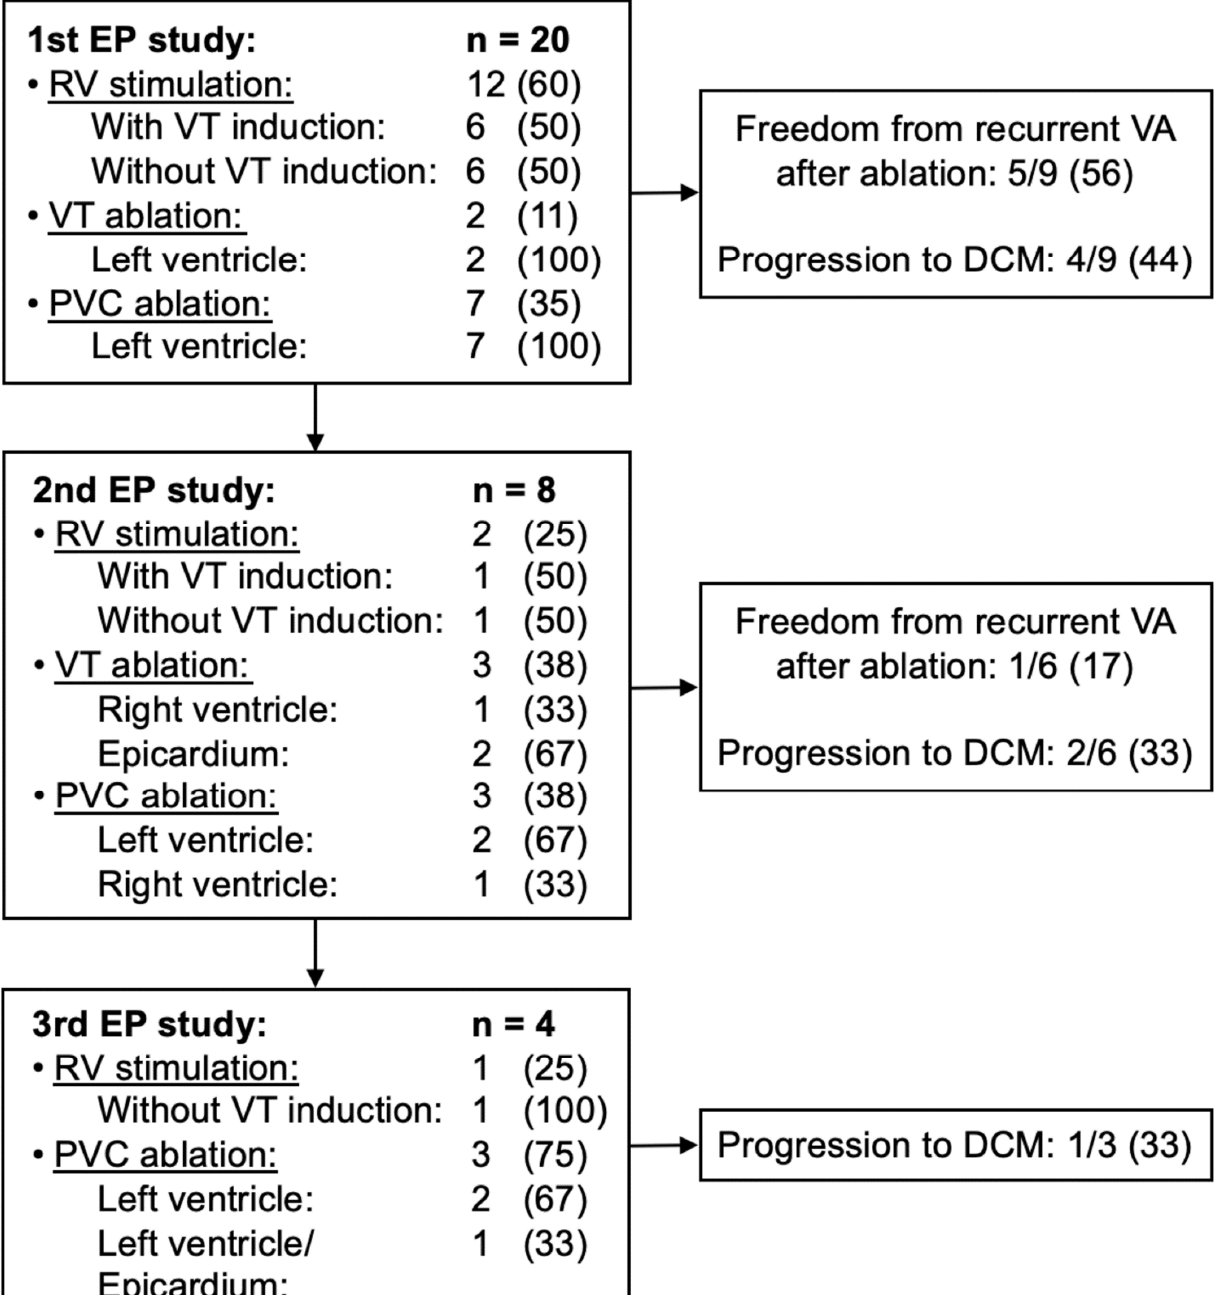
Figure 3. Ablation targets and outcome of myocarditis patients with recurrent VA. Values are indicated as n (%). DCM, dilated cardiomyopathy; EP, electrophysiological; PVC, premature ventricular complexes; RV, right ventricular; VA, ventricular arrhythmia; VT, ventricular tachycardia.